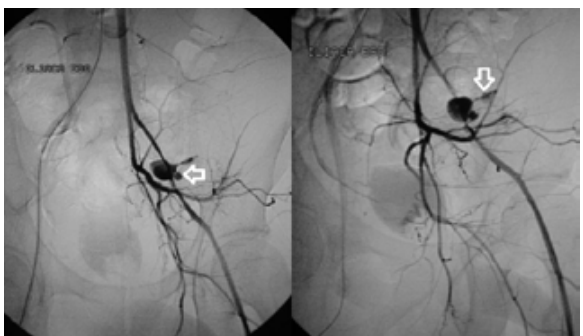
(forceps).Figure 1 - Arteriography of the patient, showing leakage of contrast medium at the left external iliac artery, compatible with pseudoaneurism (arrow to the left), with probable fistula to the colon (arrow